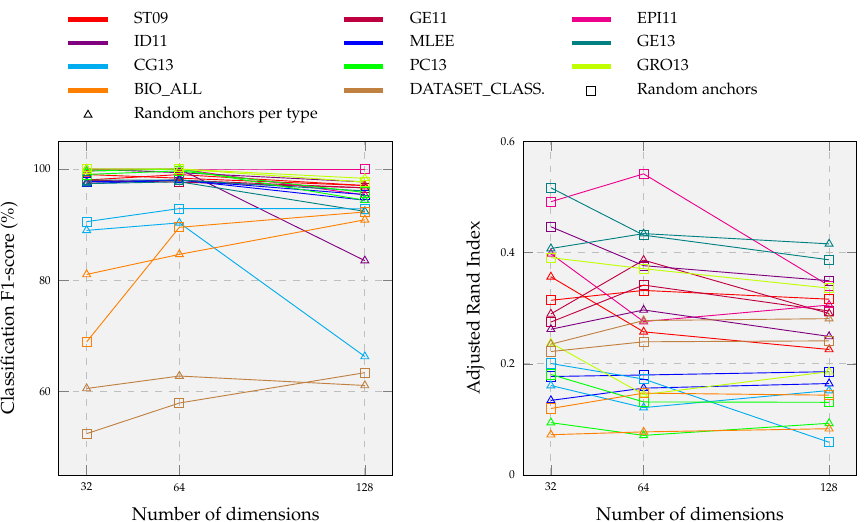
Figure 8. Effect of sub-sampling source graphs on event graph classification and clustering tasks above each biomedical dataset (colored line). We vary the number of source graphs between 32, 64, and 128, employing two different anchor strategies (marks).